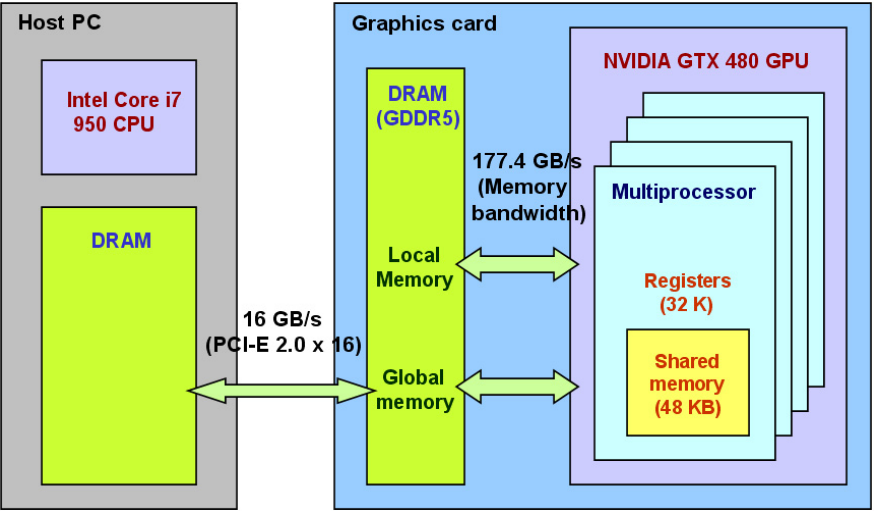
Figure 6. Memory space on a host computer and a CUDA device. Constant memory and texture memory on a CUDA device are not shown here because they are not used in our SDR